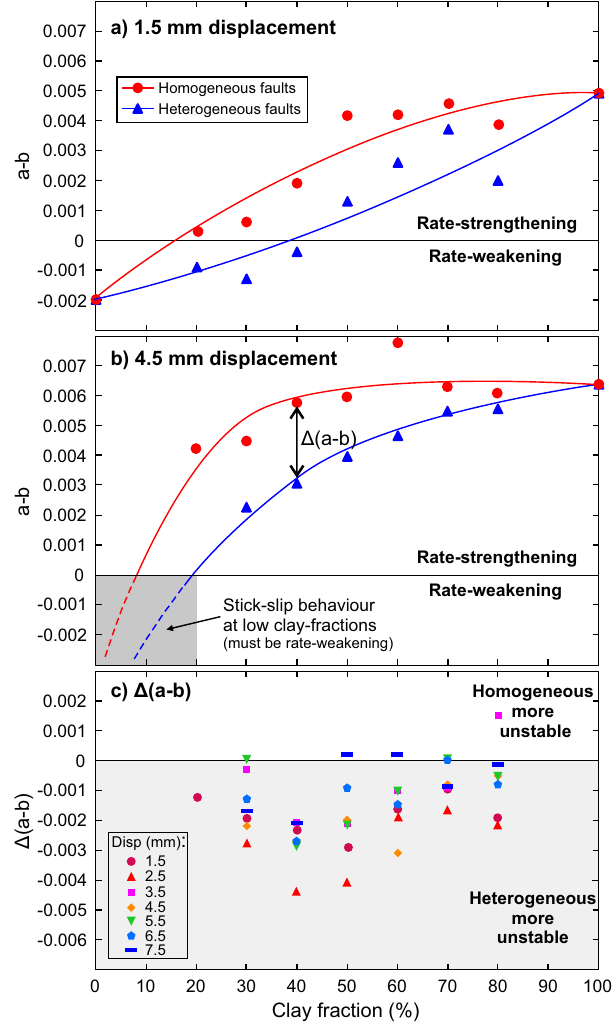
Fig. 3 Evolution of the stability-controlling rate-and-state friction parameter ( a – b ) as a function of clay content for the spatially heterogeneous and homogeneously mixed clay-quartz fault gouge layers. The ( a – b ) values are compared after ( a ) 1.5mm and ( b ) 4.5mm displacements, with the heterogeneous faults having consistently lower values than the homogeneous faults. c The difference in ( a – b ) between the heterogeneous and homogeneous faults, Δ ( a – b ), is shown for all velocity steps across the entire displacement range, with the majority of values being negative, highlighting that the heterogeneous faults are less stable than their homogeneous counterparts. Note that, for displacements larger than 1.5mm, the ( a – b ) values cannot be calculated for the homogeneous quartz fault (i.e., 0% clay fraction) or the heterogeneous fault with a 20% clay fraction, as stick-slip instabilities were triggered by the velocity